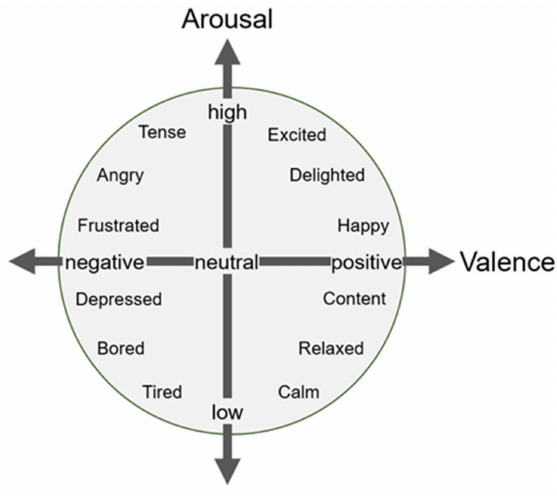
Figure 4. Valence–arousal model for emotional